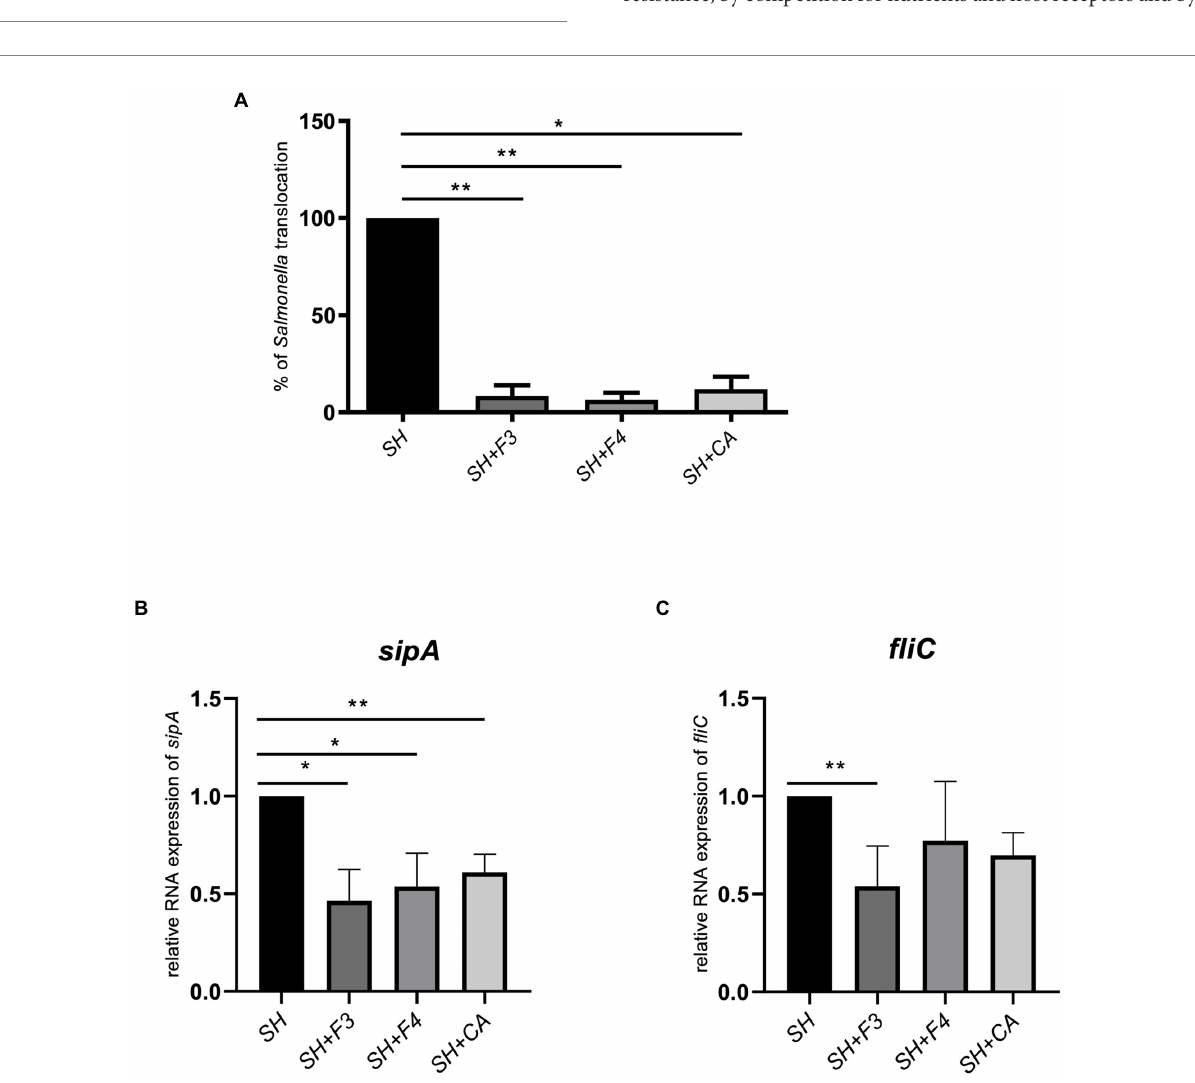
FIGURE 8 CA identified in bioactive fractions inhibited S . Heidelberg translocation in vitro . (A) Synthetic CA, at 156 μ mol/l, corresponding to the concentration found in bioactive fractions, inhibited Salmonella translocation compared to fractions F3 and F4 in the multicellular model. (B) CA downregulated only sipA expression but not fliC (C) . All results were normalized to the control Salmonella alone. All genes were reported based on the reference housekeeping gene 16S RNA. Shapiro test was performed to verify normality and one-way ANOVA test was performed on n = 5. All data were presented as means (SEM). * p < 0.05; ** p <